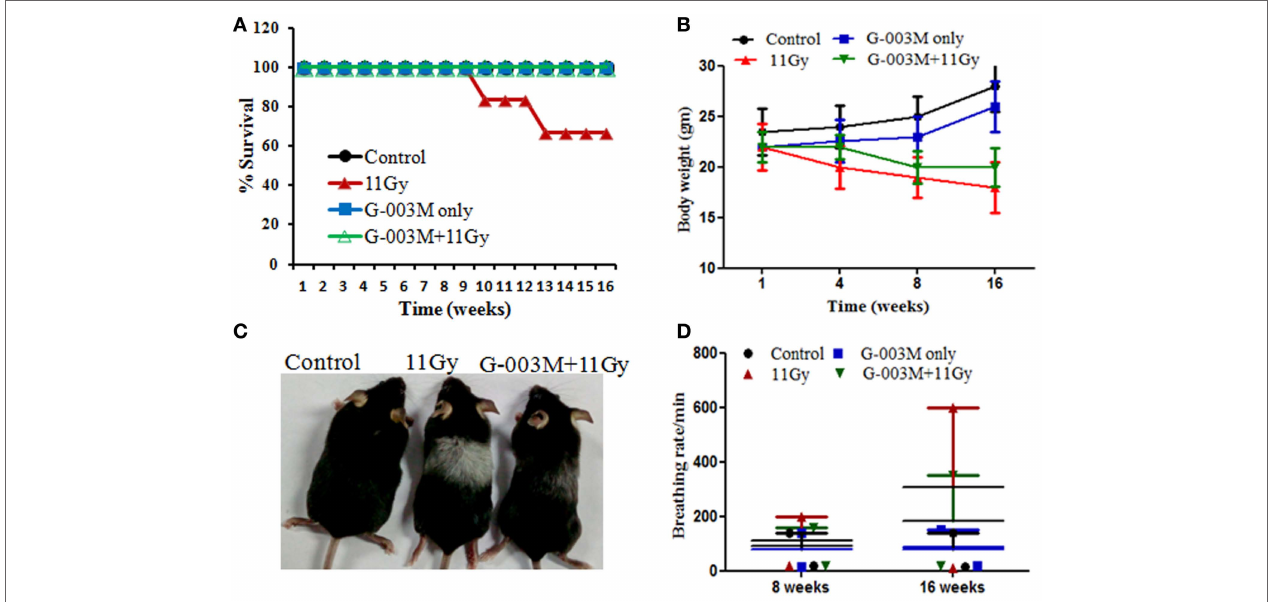
FigUre 1 | (a) Percent survival of female C57BL/6 mice (8–10 weeks old) exposed to thoracic gamma radiation (11 Gy) and pretreated with G-003M formulation. Survival was recorded up to 16 weeks postirradiation ( n = 6 for each group). (B) Body weight was recorded at different time intervals after experimentation. Data are reported as means ± SEM from six mice for each experimental group. (c) Pattern of change in hair color of mice in irradiated thoracic region. (D) Effect of G-003M on breathing rate of 11 Gy thoracic-irradiated mice. Breathing rate of individual mice was measured at 8 and 16 weeks posttreatment. Data represent the average breathing rate value obtained from six mice from each experimental